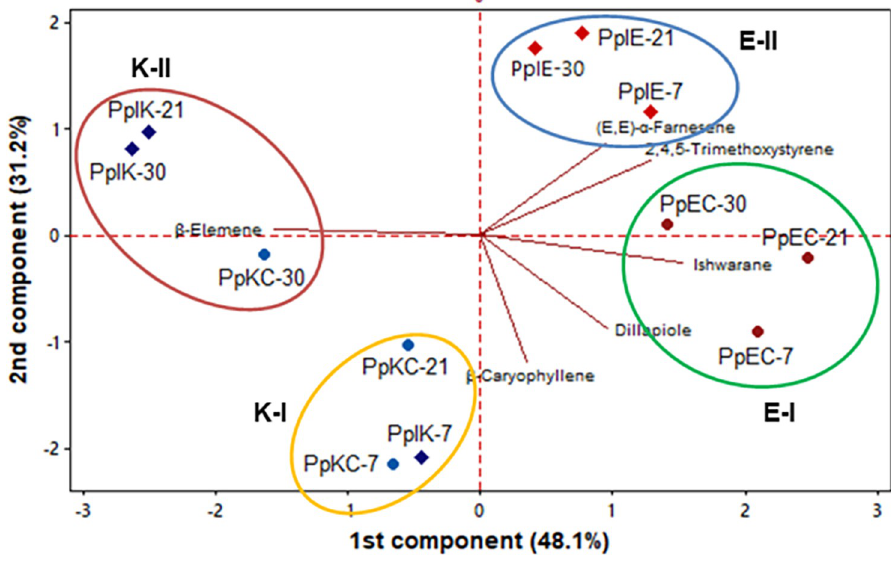
E . asburiae and K . variicola indicated potential to increase sugarcane growth [25,28]. E . asbur- iae strain EM56 and K . variicola strain EM09 were both isolated from S . amazonicum rhizo- sphere and used to inoculate P . pellucida because PGPR can be applied in all groups of plants. However, these microorganisms may have different effects on plant development and second- ary metabolism.